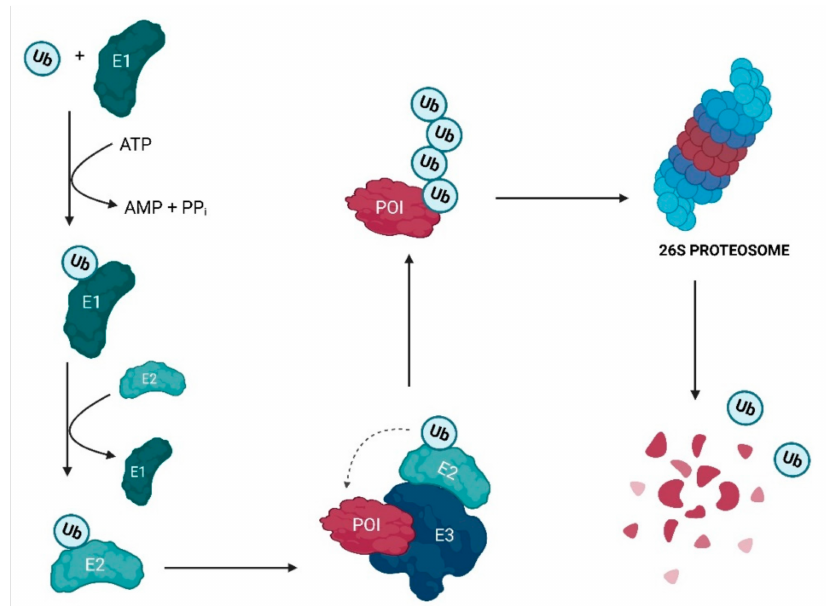
Figure 1. The ubiquitination process by the Ubiquitin-Proteasome System (UPS)—the entire ubiq- uitination process begins with the activation of the ubiquitin protein (Ub) which, by covalently binding to the ubiquitin-activating E1 enzyme, is activated in an ATP-dependent process. Upon activation, Ub is transferred to the ubiquitin-conjugating enzyme E2. Then, the simultaneous binding between E3 ubiquitin-ligase, with the protein of interest (POI), and E2-Ub occurs, with the consequent ubi-quitination of POI. The POI, being poly-ubiquitinated, is thus recognized by the 26S proteasome, resulting in its degradation